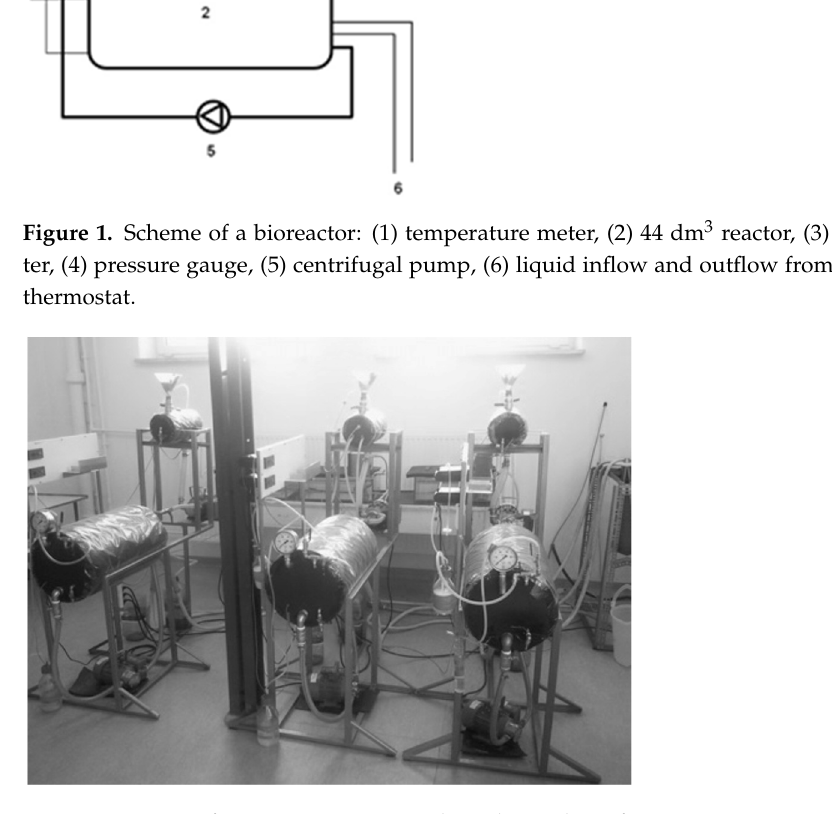
Figure 1. Scheme of a bioreactor: (1) temperature meter, (2) 44 dm 3 reactor, (3) gas quantity meter, (4) pressure gauge, (5) centrifugal pump, (6) liquid inflow and outflow from the recirculation thermostat.